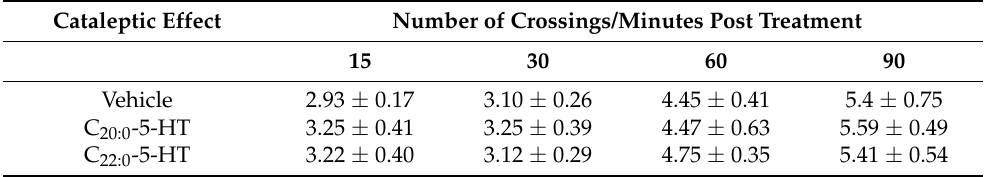
Table 3. Effect of β N -alkanoyl-5-hydroxytryptamides in the induction of a cataleptic state. Cataleptic